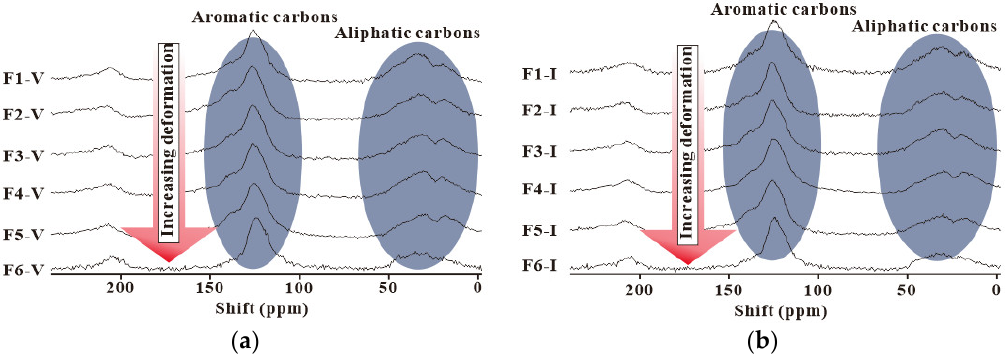
Figure 8. Nuclear magnetic resonance (NMR) spectra of vitrinite ( a ) and inertinite ( b ).